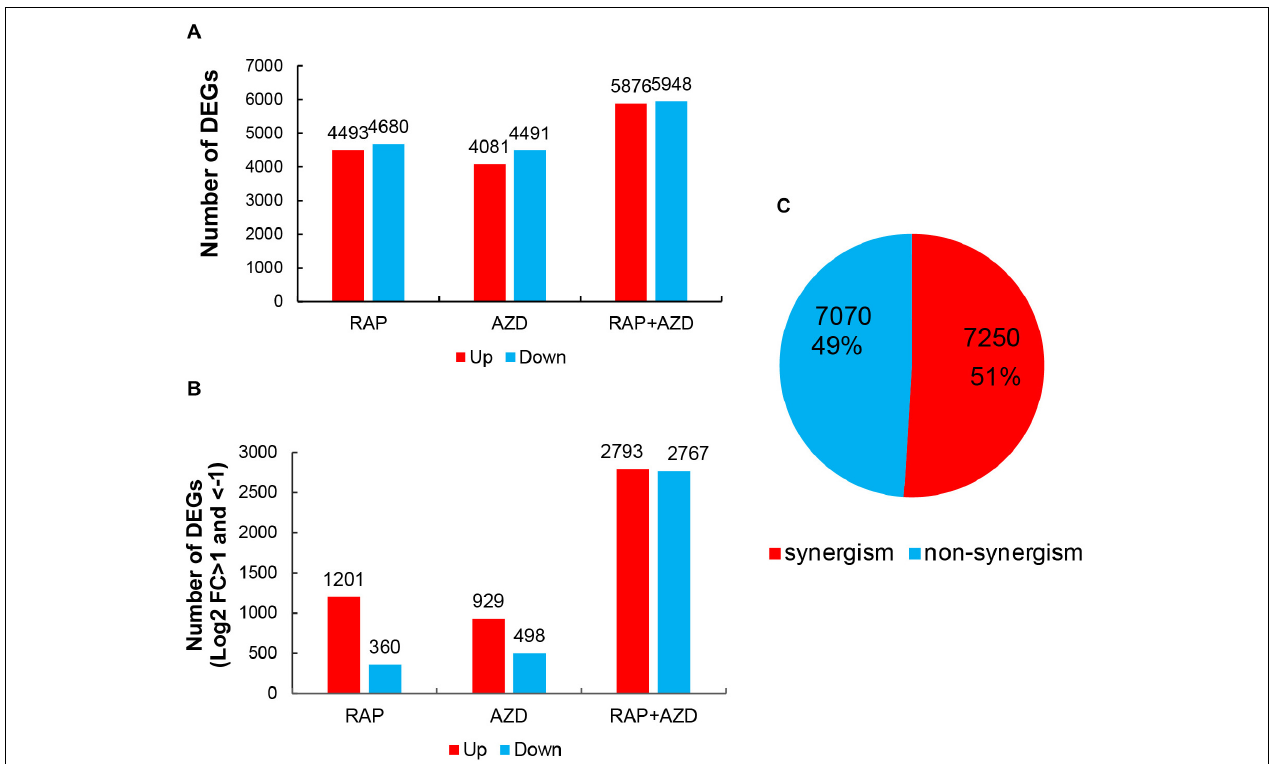
FIGURE 5 | DEGs in RAP, AZD and RAP + AZD-treated samples. (A) DEGs with Log2 foldchange > 0 or < 0 in the three samples. Red: up-regulated DEGs (Log2 foldchange > 0). Blue: down-regulated DEGs (Log2 foldchange < 0). (B) DEGs with Log2 foldchange > 1 or < –1. (C) Synergism and non-synergism of DEGs. [Synergistic DEGs: | gene expression of (RAP + AZD)| > | gene expression of (RAP/AZD